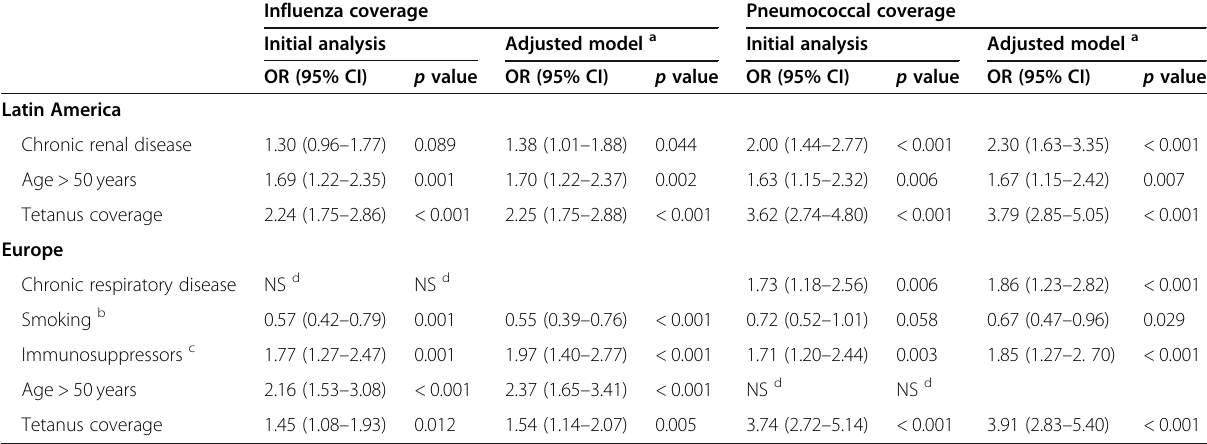
Table 6 Factors associated with vaccination coverage* Influenza